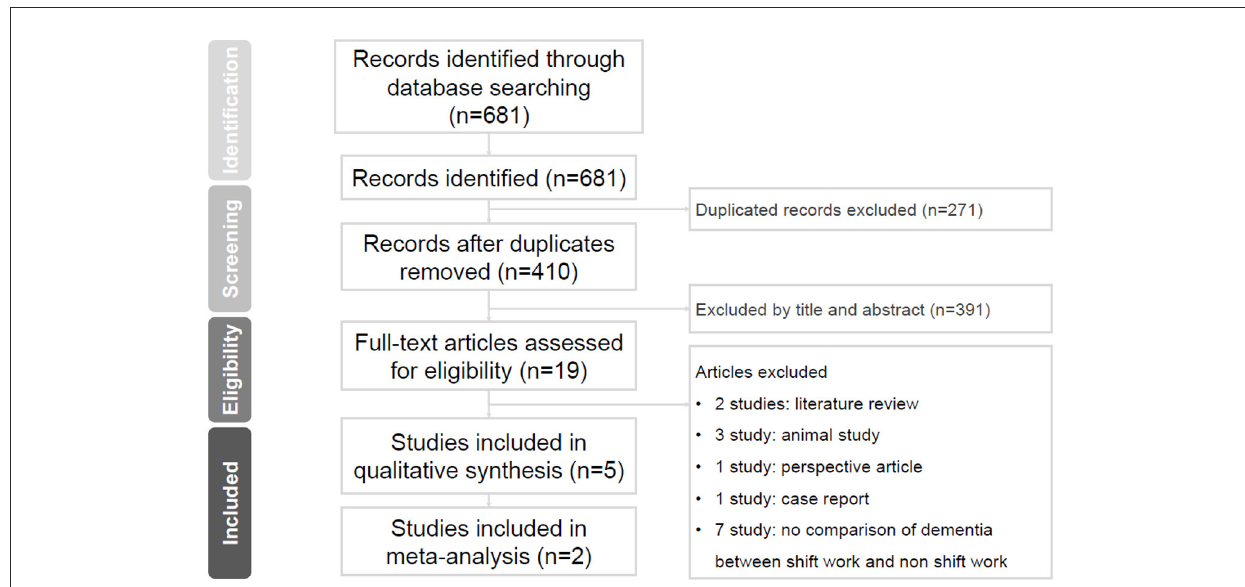
FIGURE1 Preferred reporting items for systematic reviews and meta-analyses (PRISMA) flow